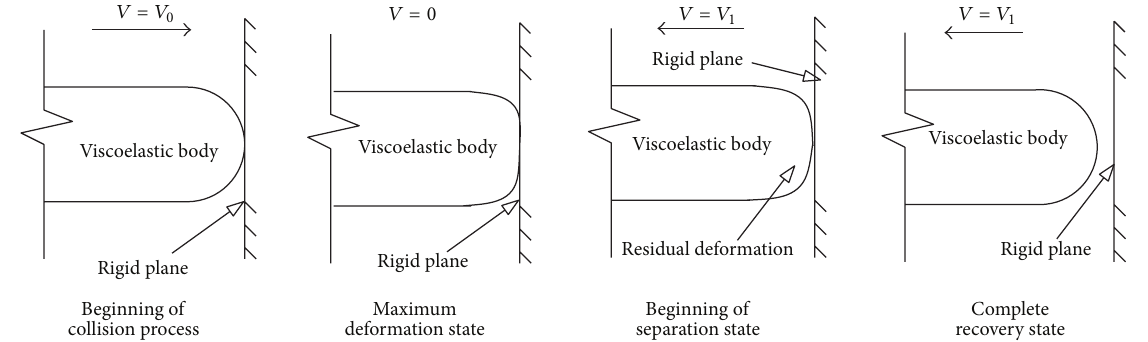
Figure 15: Collision process for viscoelastic